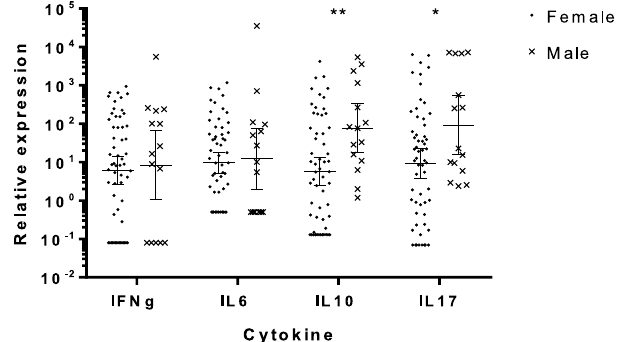
Figure 3. The effect of sex on cytokine expression. Geometric mean and 95%CI of the geometric mean for relative expression of cytokine levels, compared to reference genes calculated using the Δ Cq method 67 . IL10 and IL17A were significantly greater in males ( * p < 0 . 05 , ** p < 0 . 01 Mann - Whitney U